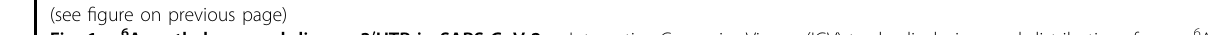
Fig. 1 m 6 A methylome and diverse 3 ′ UTR in SARS-CoV-2. a Integrative Genomics Viewer (IGV) tracks displaying read distributions from m 6 A MeRIP-seq (upper panel) and RNA-seq (lower panel) along SARS-CoV-2 positive-sense RNA. The green rectangles at the bottom depict the positions of identi fi ed m 6 A peaks. b Pie chart showing the fraction of m 6 A peaks in different segments along SARS-CoV-2 RNA genome. c Line chart revealing m 6 A peak numbers per 1 kb for each segment along SARS-CoV-2 RNA genome by normalizing with its length, respectively. The diamonds represent UTRs and dots represent CDS regions along complete SARS-CoV-2 genomic RNA. d Pie chart depicting the proportion of m 6 A peaks containing RRACH (yellow) or not (blue). e Histogram showing the frequency of RRACH peak number in 1000 simulated peak pools of SARS-CoV-2 genome. f Pie chart showing proportion of reads annotated as Chlorocebus sabaeus mRNA (green), ncRNA (yellow), and SARS-CoV-2 RNA (blue). g IGV tracks showing read distribution from RNA-seq along SARS-CoV-2 RNA in both control (upper panel) and METTL3-depleted Vero cells (lower panel). The read counts were normalized by ERCC for each batch, respectively. h Heatmap showing the frequency of junction-spanning reads along SARS-CoV-2 RNA genome from control (left) and METTL3-depleted Vero cells (right). The counts were aggregated into 100-nt bins for both axes. i Models present four different types of junction-spanning reads. (a) TRS-L-dependent, canonical fusion mediated by TRS-L and TRS-B; (b) Random 3 ′ acceptor represents noncanonical fusion mediated by TRS-L but not TRS-B; (c) Random 5 ′ donor represents long-distance fusion mediated by TRS-B but not TRS-L; (d) Random inner junction identi fi ed as TRS-independent spanning. j Pie chart showing the proportions of four different types of junction- spanning reads. k Scatterplot showing the relative expression levels of four different junction-spanning transcripts in control and METTL3-depleted Vero cells which were presented in different colors, respectively. The blue circle represents the spanning-junctions located in 3 ′ UTR. l IGV tracks displaying read distribution from m 6 A MeRIP-seq along SARS-CoV-2 RNA genome in both control and METTL3 knockdown samples. The green rectangles depict the positions of m 6 A peaks identi fi ed in control samples and yellow triangles at the bottom represent peaks with signi fi cant decreased methylation level in METTL3 knockdown